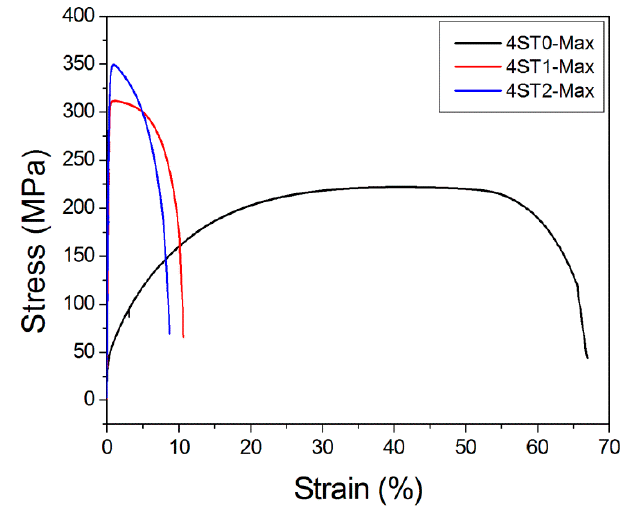
Figure 14. Stress–strain curves of 4ST0, 4ST1 and 4ST2 for Max.